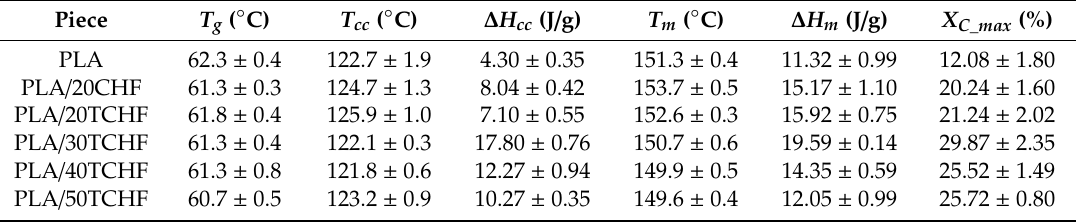
Table 3. Thermal properties of the injection-molded pieces of polylactide (PLA) with co ff ee husk flour (CHF) and torrefied co ff ee husk flour (TCHF) in terms of glass transition temperature ( T g ), cold crystallization temperature ( T cc ), melting temperature ( T m ), cold crystallization enthalpy ( ∆ H cc